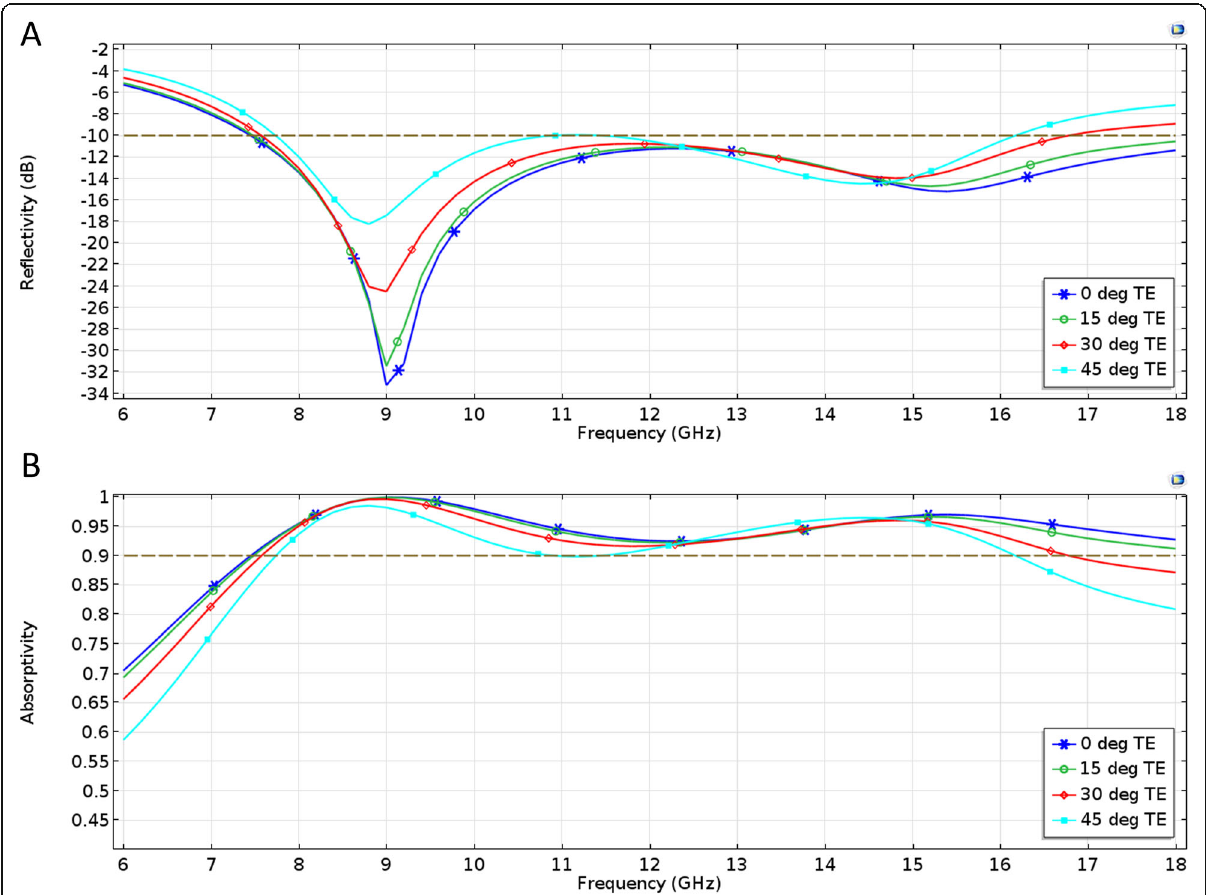
Fig. 9 Simulated reflectivity ( a ) and absorptivity ( b ) of the optimized structure at normal and oblique incidence for TE-polarized